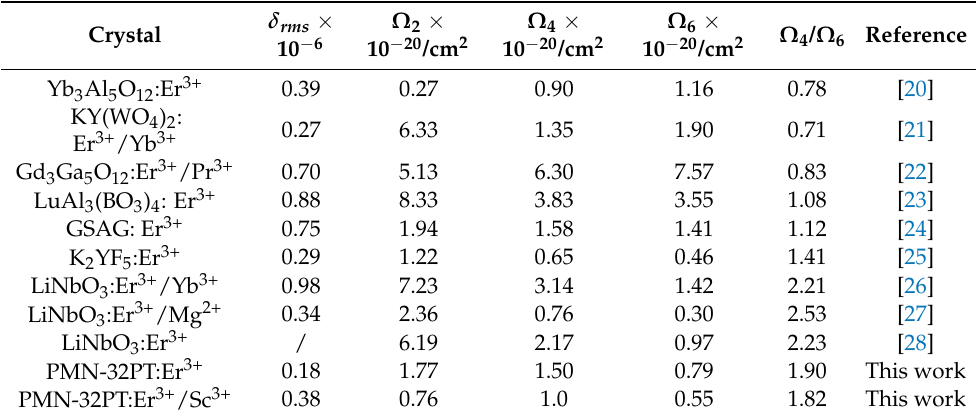
Table 4. The J-O intensity parameters Ω t ( t = 2, 4 and 6) of Er 3+ in different